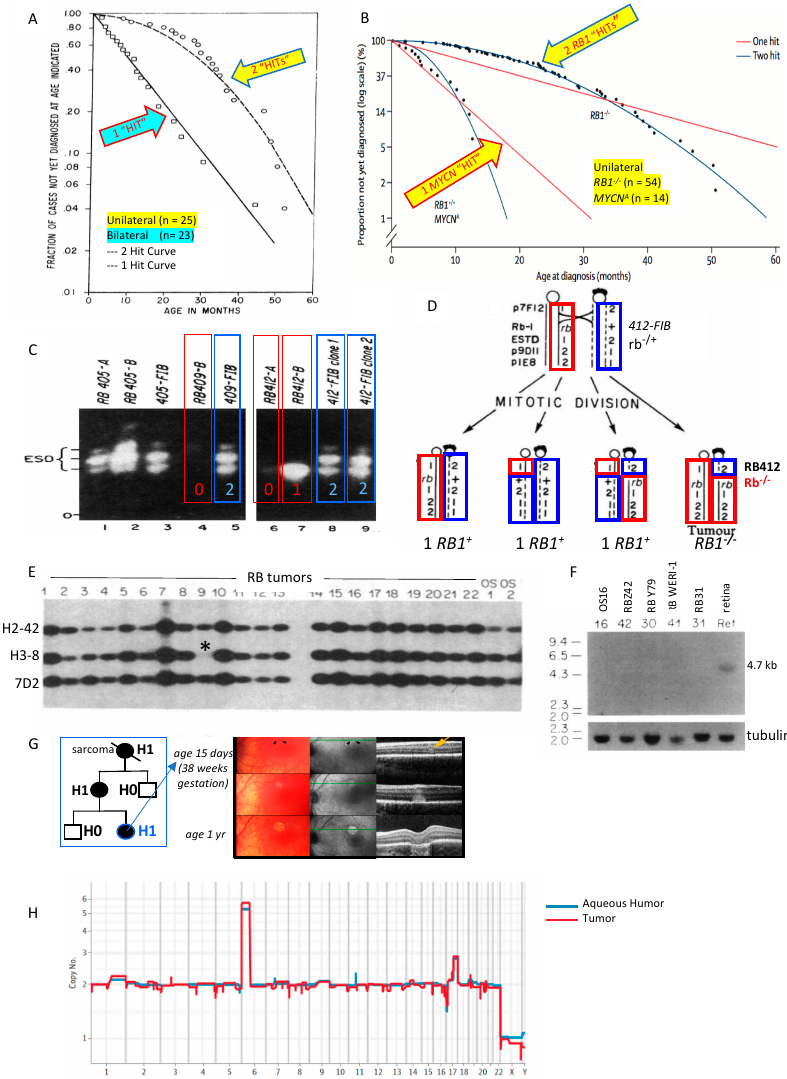
Figure 1. The RB1 story. ( A ) Knudson evaluated age at diagnosis vs. proportion not diagnosed; two hits initiated unilateral retinoblastoma and only one hit was required for bilateral patients predisposed to retinoblastoma [1]. ( B ) A rare third form of unilateral, non-hereditary retinoblastoma has normal RB1 alleles and instead is driven by one hit: high-level amplification of the oncogene MYCN (reproduced from [23], with permission). ( C ) Inactivation in tumor of esterase D alleles near the retinoblastoma susceptibility locus suggested regional somatic inactivation was the second hit in some retinoblastoma tumors [10]. ( D ) Mitotic recombination results in loss of heterozygosity around RB1 locus so that cells that form the retinoblastoma tumor have lost both copies of normal RB1 [11,12]. ( E ) Retinoblastoma tumor 9 (of 22) has homozygous deletion of H-38 probe (*) that mapped in the 13q14 genomic region [16]. ( F ) The RB1 tumor suppressor gene is cloned: a conserved DNA sequence near H-38 probe hybridized to a 4.7 kb messenger RNA found in all normal tissues but not in retinoblastoma or osteosarcoma tumors [17]. ( G ) Persons carrying a RB1 pathogenic variant are H1 (at risk for retinoblastoma and second cancers); prenatal detection and early term delivery facilitates detection and laser treatment of invisible tumors with minimal scarring (reproduced from [60], with permission). ( H ) Cell-free DNA from fluid behind the cornea (aqueous humor) shows the same pattern of copy number changes characteristic of retinoblastoma as the tumor from the removed eye (reproduced from [62], with